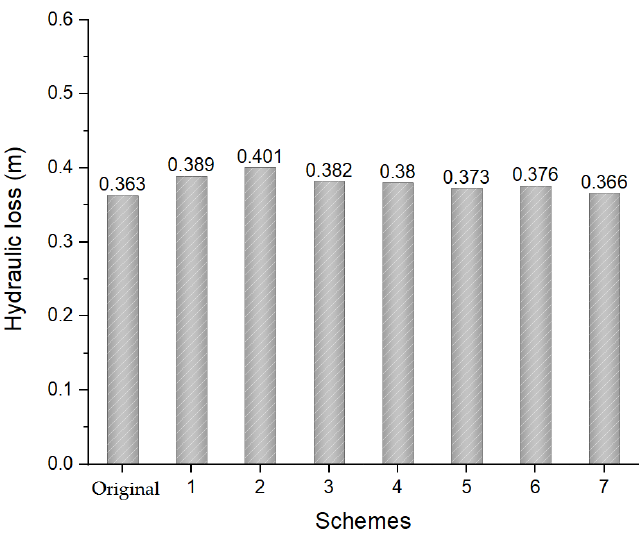
Figure 11. Hydraulic loss trend chart of each